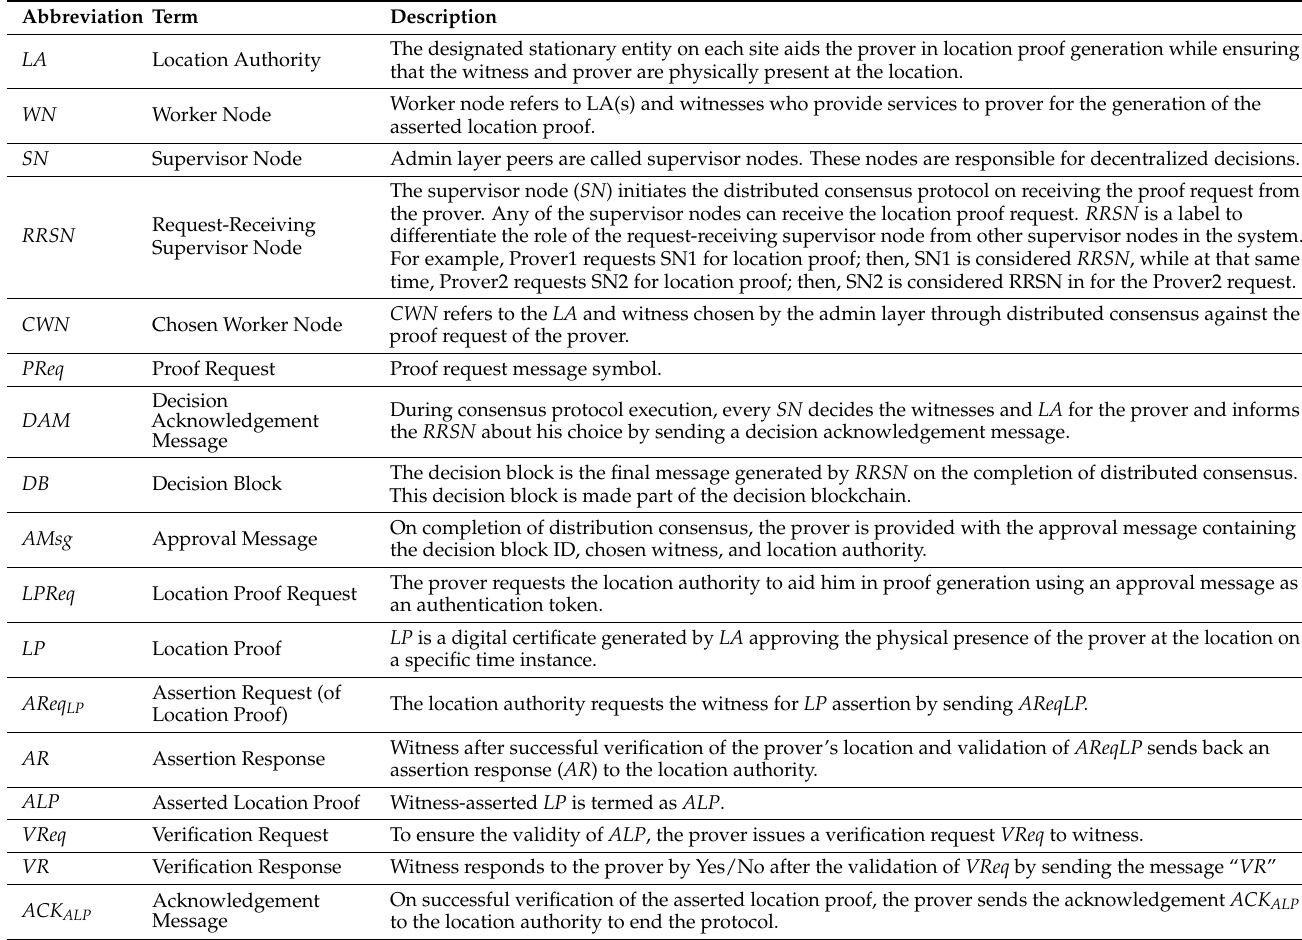
Table 1. Abbreviations and their